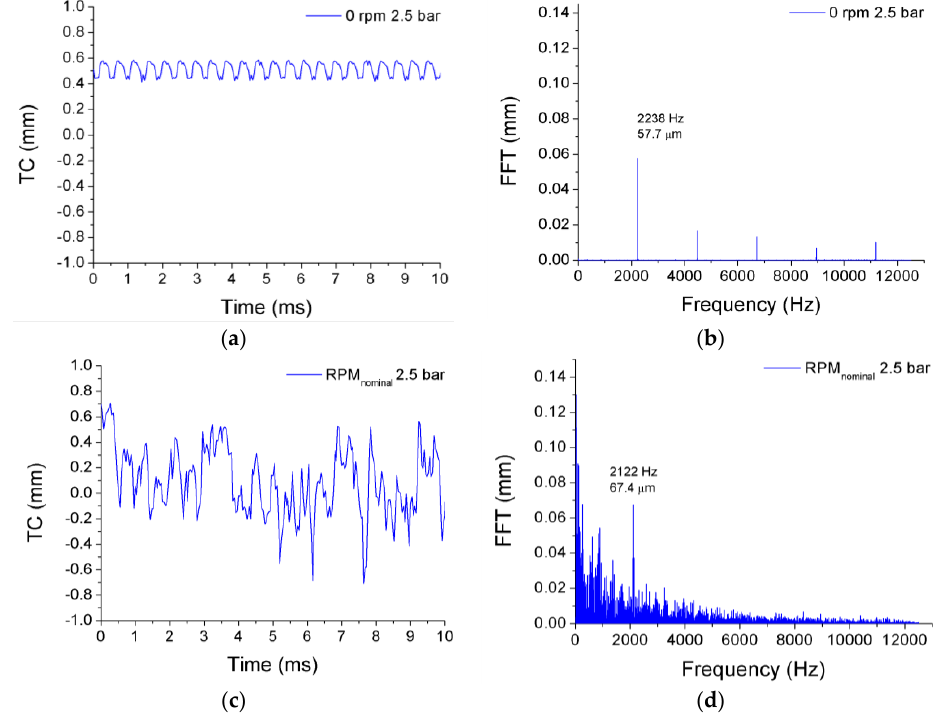
Figure 6. Time domain signals and their FFTs for OFS 1 when the disk is not rotating ( a , b ) and when it is turning at its nominal speed ( c , d ). Clear peaks appear at f os = 2238 Hz and f os = 2122 Hz, respectively.